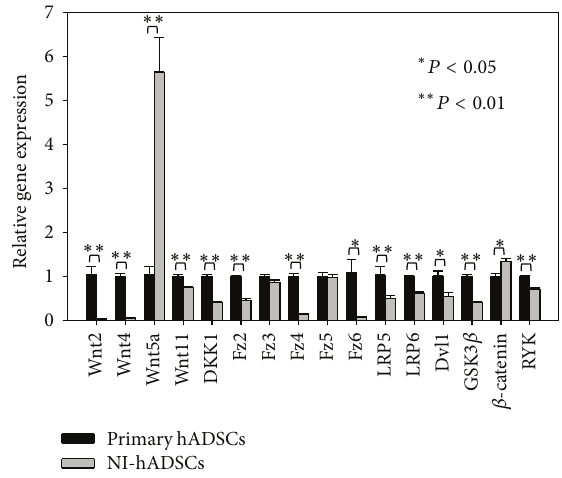
Figure 2: Real time RT-PCR analysis of Wnt pathway-related genes. Real time RT-PCR was performed to confirm the RT-PCR assay. The expressions of Wnt5a and 𝛽 -catenin are increased and others are decreased in NI-hADSCs, significantly. Fz3 and Fz5 expressions are not changed. The real time RT-PCR assay was repeated four times independently of different cells and the representative data are shown. The intensity of each gene was normalized to GAPDH. ∗ 𝑃 < 0.05 , ∗∗ 𝑃 < 0.01 compared with the primary hADSCs.